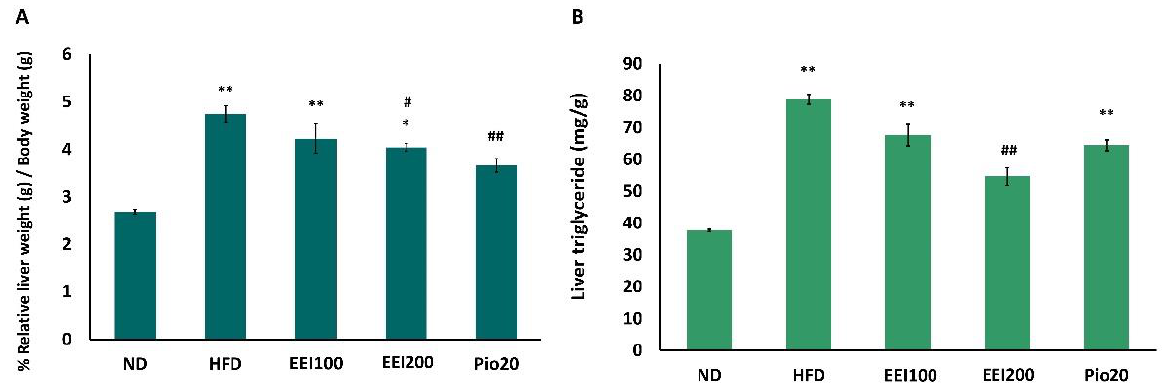
Figure 4. The effect of 2-week feeding EEI on %relative liver weight/body weight ( A ) and liver triglycerides (mg/g) ( B ). Results are presented as the means ± SEM ( n = 10). Significant differences were presented as * p < 0.05 and ** p < 0.01 compared to the ND group, # p < 0.05 and ## p < 0.01 compared to the HFD group. ND = Normal diet-fed rats treated with vehicle; HFD = High fat diet-fed rats treated with vehicle; EEI100 = HFD-fed rats treated with 100 mg/kg/day of EEI; EEI200 = HFD-fed rats treated with 200 mg/kg/day of EEI; Pio = HFD-fed rats treated with 20 mg/kg/day of pioglitazone.